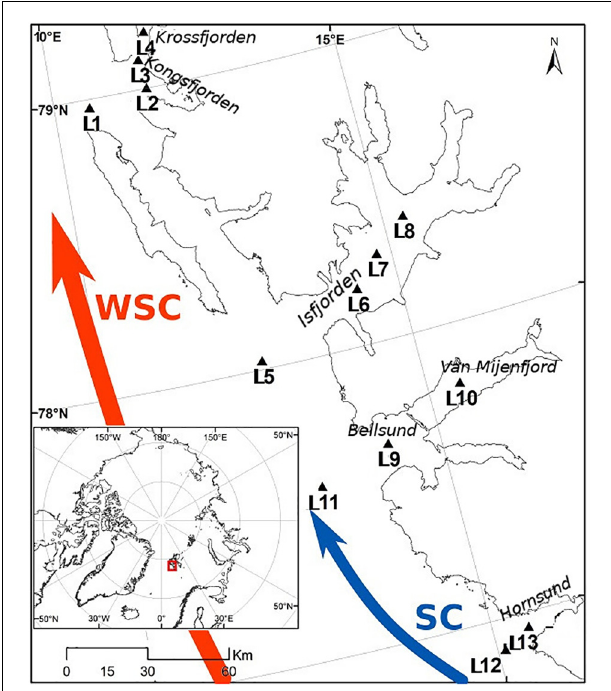
FIGURE 1 | All of the considered study locations (also excluded L4) within Svalbard Fjords with the cold Sørkapp Current (SC) marked in blue and the warm West Spitsbergen Current (WSC) marked in red (shoreline: Wessel and Smith,